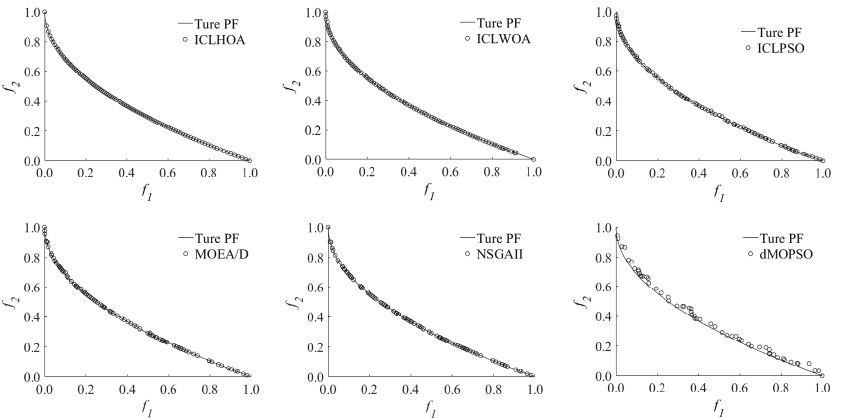
Figure 9. ZDT1 PF of each optimization